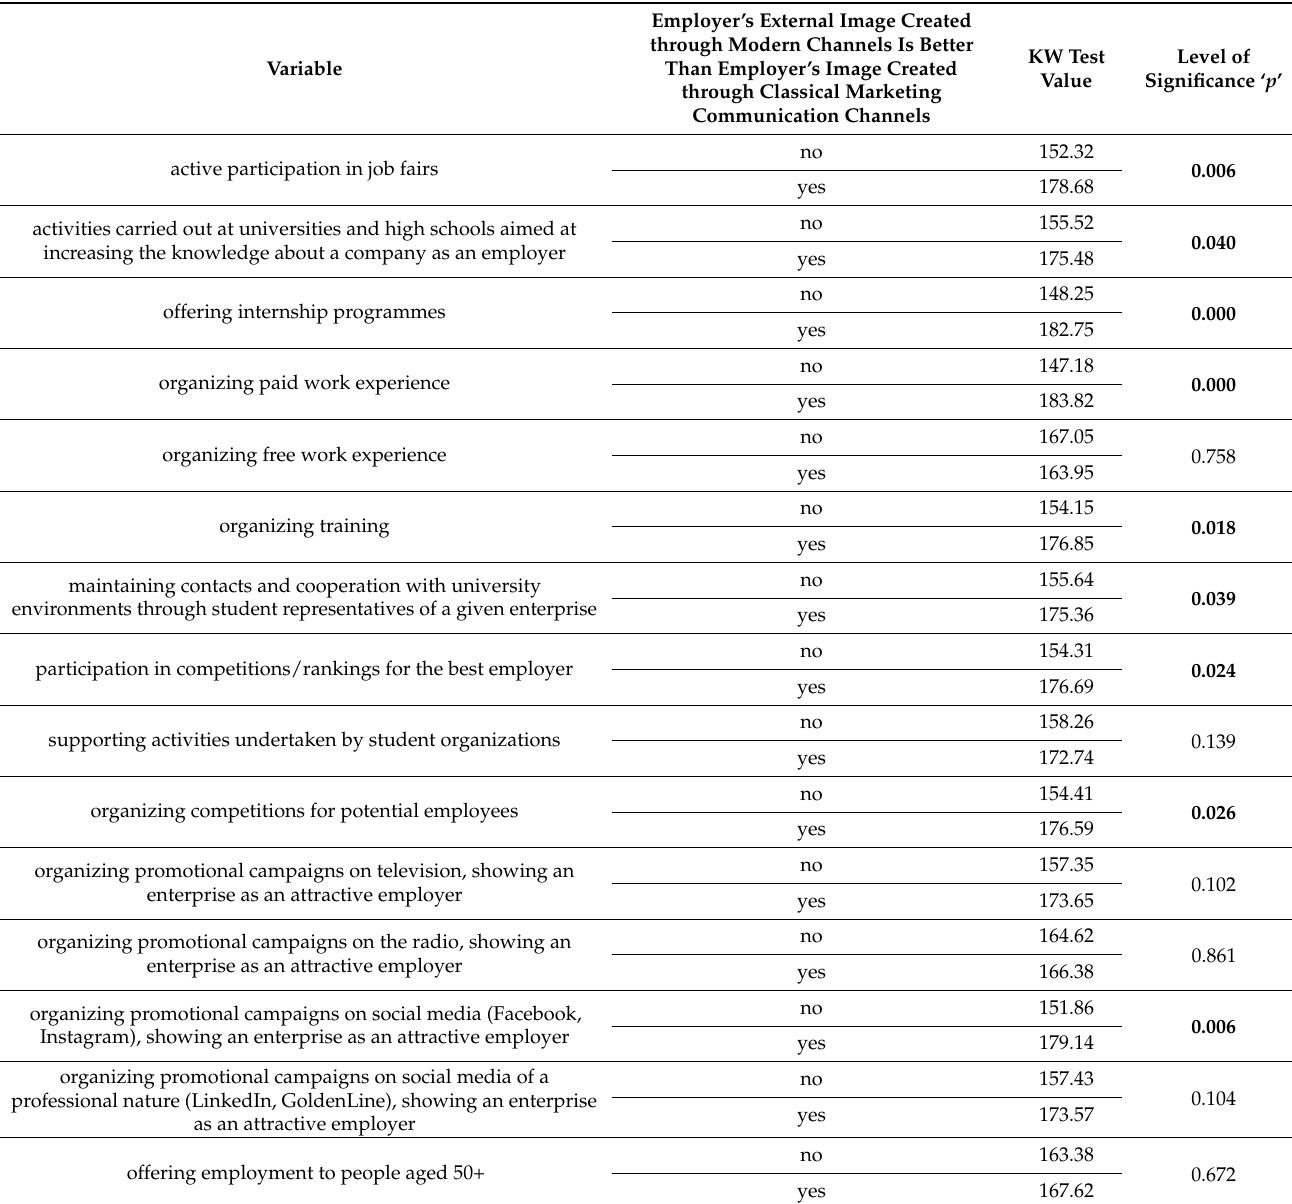
Table 4. Significance of differences between responses regarding actions undertaken by enterprises depending on respon- dents’ opinions on whether the employer’s image created on the basis of modern marketing communication channels is more beneficial than the employer’s image created on the basis of classical marketing communication